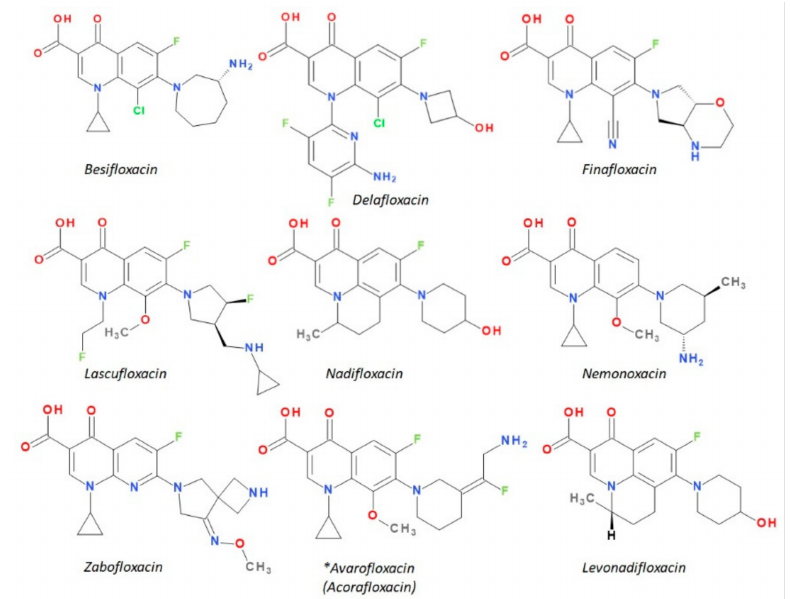
Figure 4. Chemical structures of newer approved antibacterial QNs (*final stage of